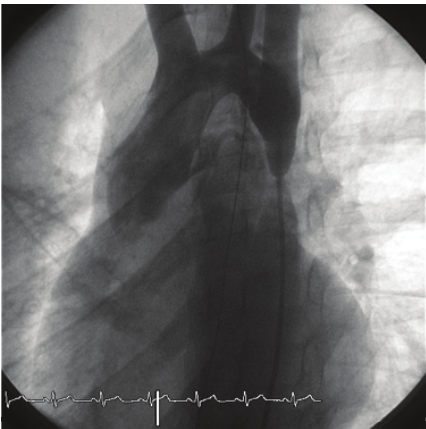
Figure 2: 30 ∘ left anterior oblique view: stent positioning across the stenosis.